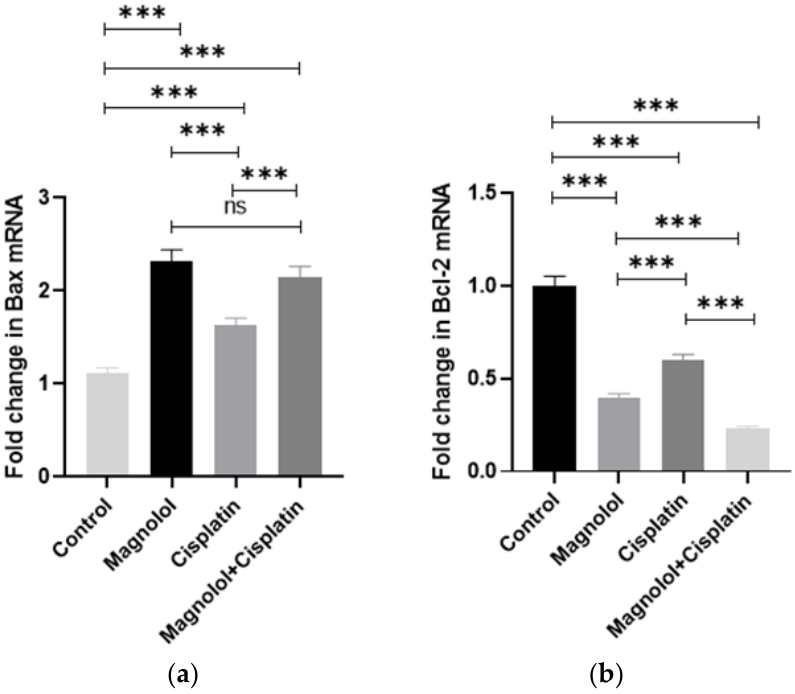
Figure 4. Changes in apoptotic-related genes following magnolol and/or cisplatin therapy. ( a ) A substantial increase in Bax expression after magnolol and/or cisplatin application. ( b ) A significantly decreased level of Bcl2 expression after magnolol and/or cisplatin application. β -actin was used as the reference gene for normalizing the relative quantitative expression of target genes. All experiments were performed in triplicate. *** p < 0.001, ns: not